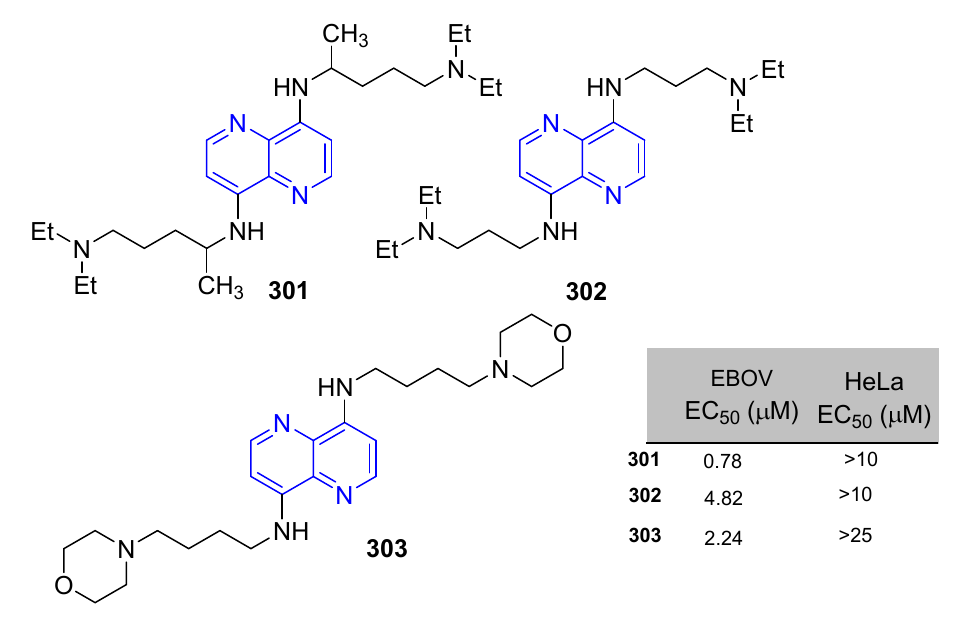
Figure 25. Anti-EBOV pharmacophores.